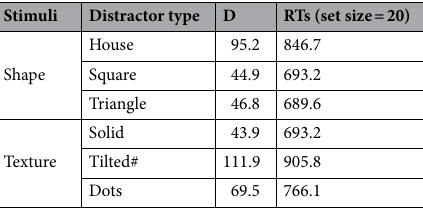
Table 1. Logarithmic search efficiency ( D ) in Experiments 1A and 1B as well as reaction times (RTs) at set size 20.